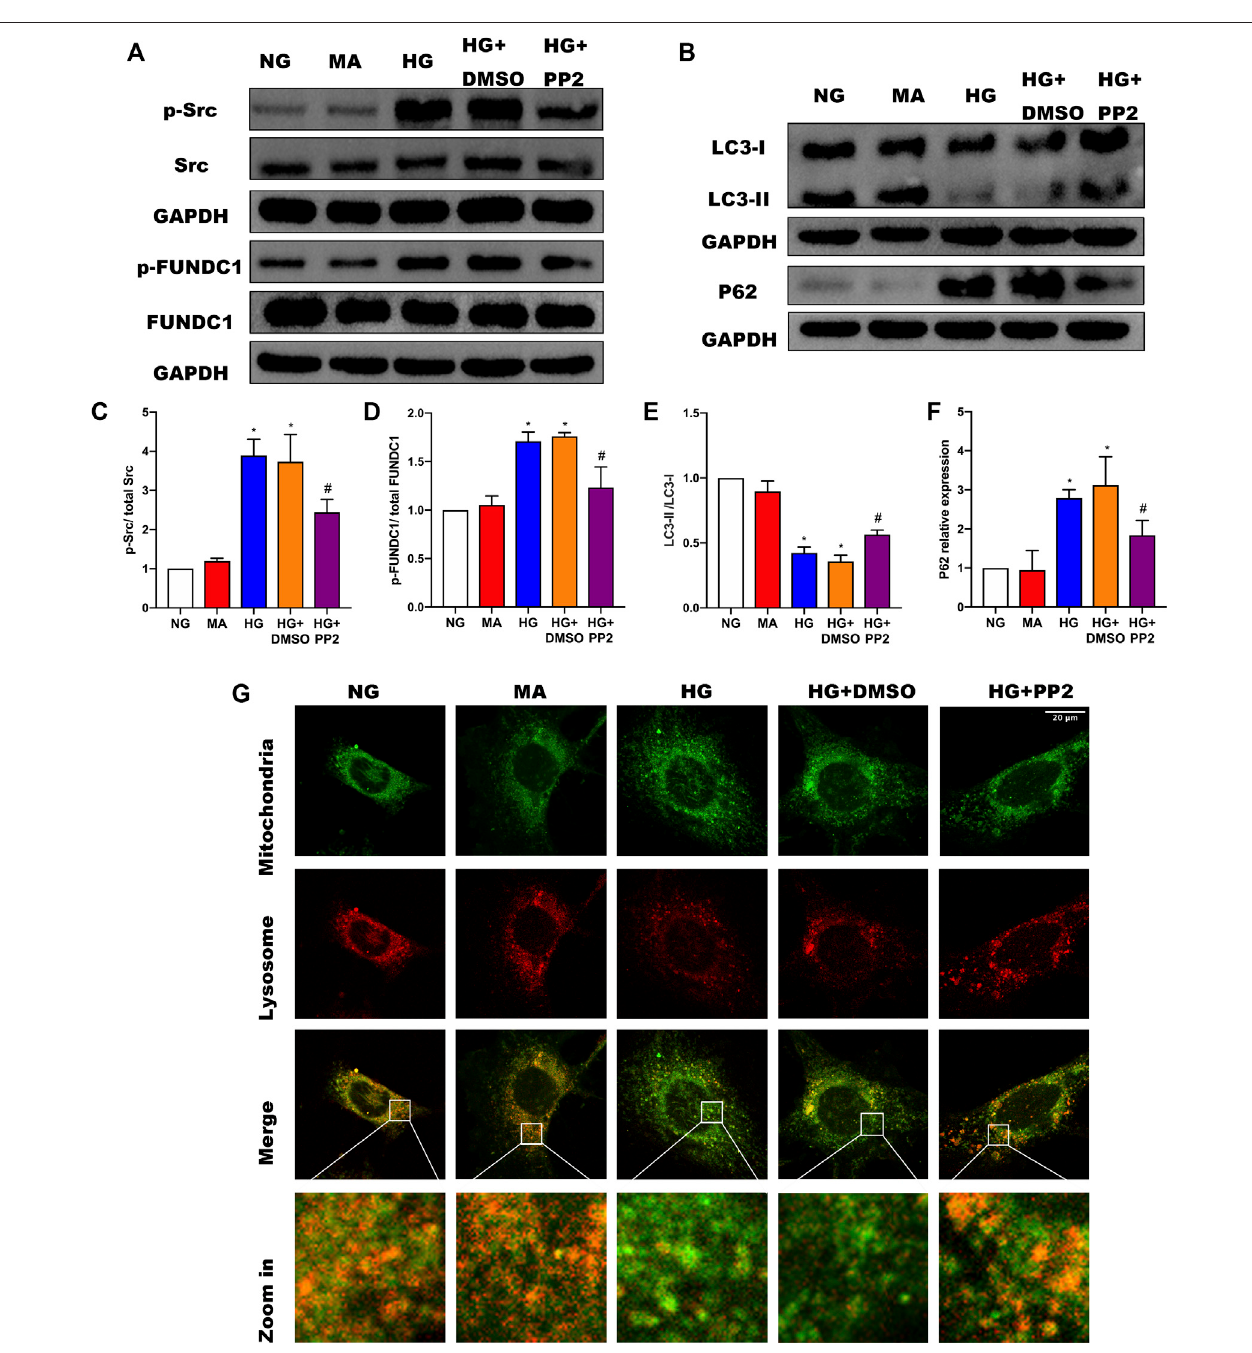
FIGURE 4 | Src activation was upregulated in response to high glucose and inhibits FUNDC1-mediated mitophagy in human podocytes. (A) Representative Western blot images of Src, p-Src, FUNDC1 and p-FUNDC1 expression. (B) LC3 and P62 expression in podocytes after the indicated treatments. (C – F) Quanti fi cation of Western blot band intensities of the different proteins from (A,B) ; GAPDH was used as loading control. (G) Co-immuno fl uorescence staining for mitochondria and lysosome to observe changes in mitophagy in podocytes after the indicated treatments. (Magni fi cation, 1000 ×) Co-localization of mitochondria and lysosome indicated the occurrence of mitophagy. The fragmented mitochondria could not be engulfed by lysosomes after HG treatment, as illustrated by only the sporadic co- localization of mitochondria and lysosome, indicating that mitophagy was inhibited. These changes were reversed by PP2 treatment, which facilitated fusion of mitochondria and lysosomes.NG, normal glucose; MA, mannitol; HG, high glucose. Values are expressed as the mean ± SD, * p < 0.05 vs. NG group, # p < 0.05 vs. HG group.